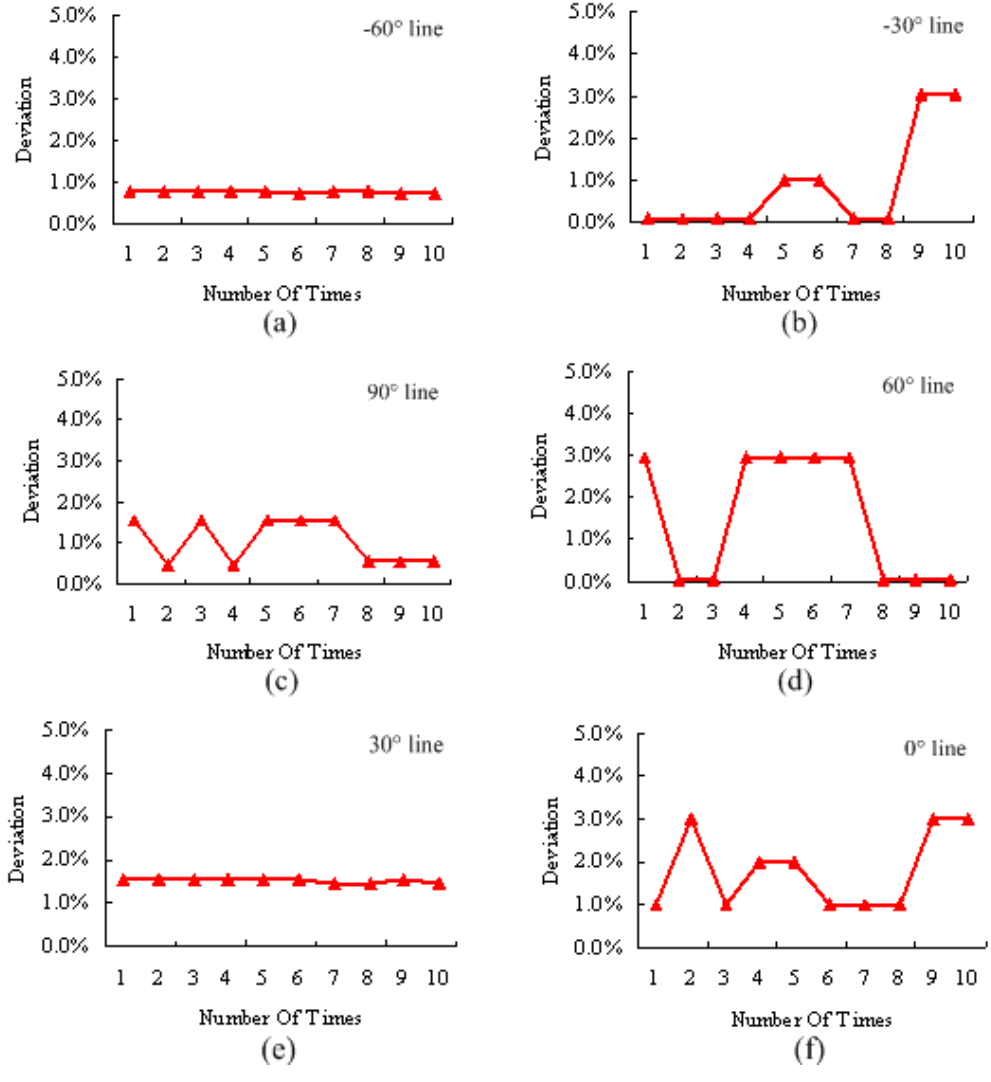
Figure 18. The deviations of tested angles. ( a ) deviation of –60° angle line; ( b ) deviation of –30° angle line; ( c ) deviation of 90° angle line; ( d ) deviation of 60° angle line; ( e ) deviation of 30° angle line; ( f ) deviation of 0° angle line.